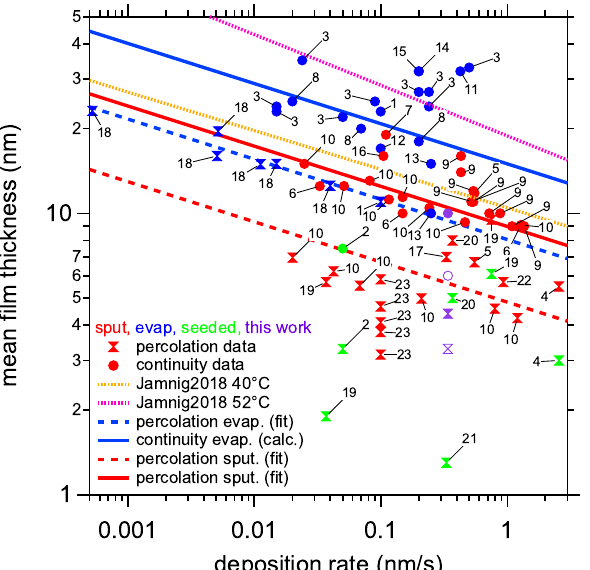
Figure 9. Reported percolation (hourglass symbols) and continuity (round) thresholds for silver thin films deposited at room temperature using different techniques. Red symbols are for energetic techniques (mainly sputtering), while blue symbols are for evaporation and e-beam experiments. Green markers are for seeded layers. The seed material is mentioned in the reference list. The full (striped) blue and red lines are fitted (calculated) power laws with an exponent − 1/7 (see text). The orange and purple lines are reproduced from the work of Jamnig et al. for films deposited at 40 and 52 ◦ C, respectively. The violet markers are used for this work (full and open marker for non-seeded and seeded layer, respectively). Data taken from: (1) [39], (2(Ge)) [40], (3) [41], (4(Cu))[42], (5)